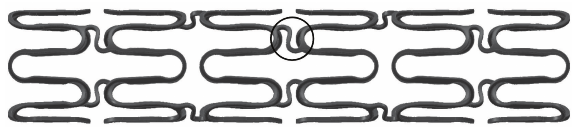
Figure 2: Supraflex sirolimus-eluting stent: a schematic view of the stent structure (circle shows flexible